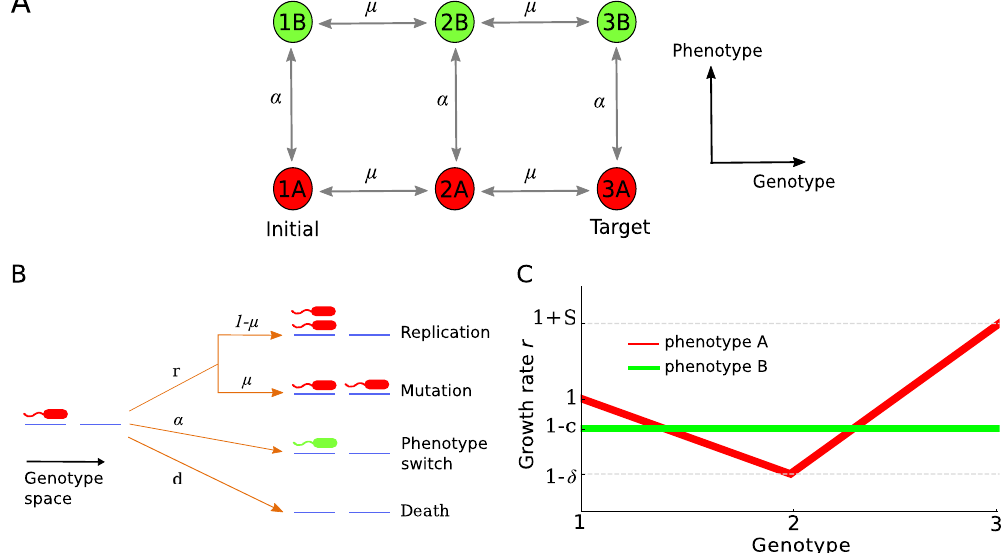
Figure 1. The model. ( A ) Diagram showing the six possible states of a cell and the available transitions between them. The genotypes are labelled 1, 2 and 3, the phenotypic states are labelled A and B. Transitions between genotypes/phenotypes occur at rates μ and α , respectively. All cells are initially in state 1A. Evolution continues until a single cell reaches the target state 3A. ( B ) Each cell can replicate, switch phenotype, or die with rates r , α and d respectively. Upon replication a cell has the probability μ of producing a mutant of each neighbouring genotype. ( C ) The fitness landscapes for both phenotypes. Phenotype A has a fitness valley at 2A while phenotype B has uniform fitness across all genotypes.